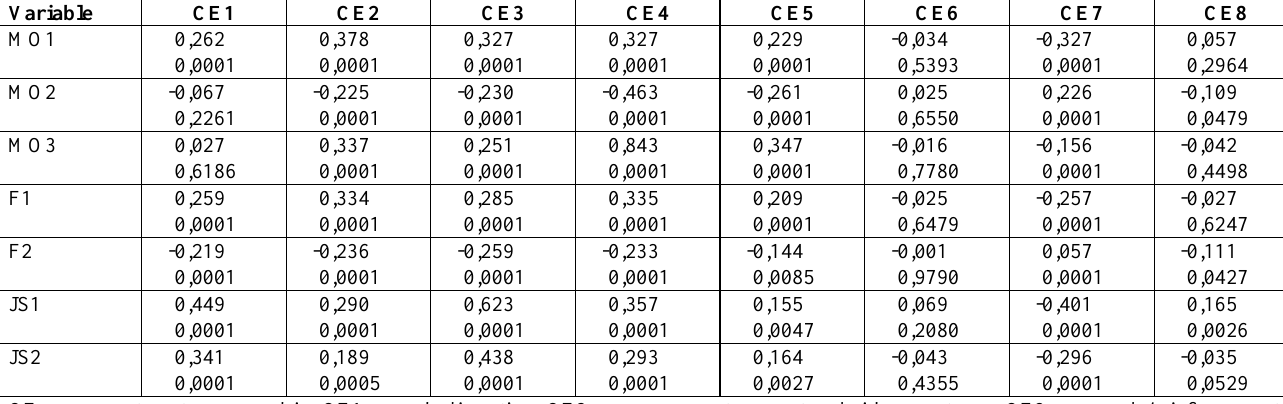
Table 1: Pearson product moment correlations for corporate entrepreneurship and variables of market orientation, job satisfaction and flexibility (N = 333)